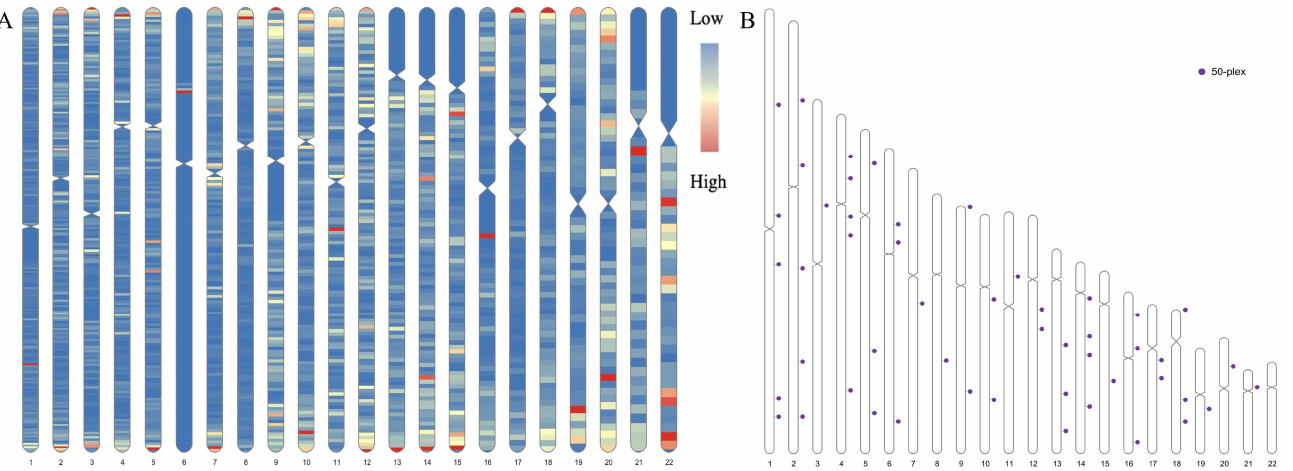
Figure 2. Distribution of target microhaplotypes (MHs). ( A ) Distribution of MHs within 80 bp consisting of 2 or more single nucleotide polymorphisms (SNPs) in the Chinese Southern Han (CHS) and effective number of alleles (A e ) values ≥ 3. The “low” and “high” represent the distribution densities of the target MHs. ( B ) Physical locations of the final 50 MHs.